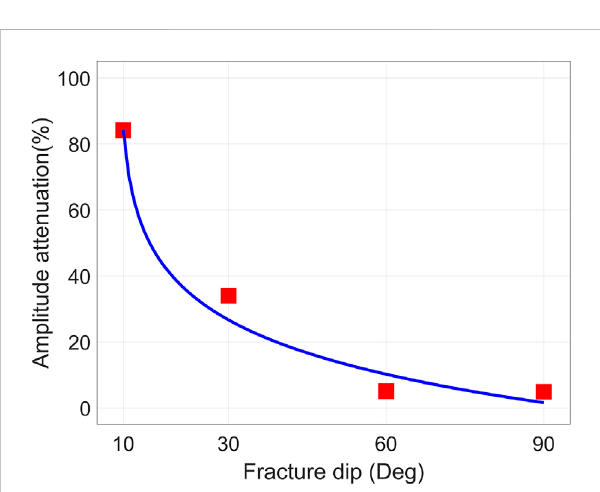
FIGURE 9 Amplitude attenuation of monopole P wave versus different fracture dipangles. Thefracturewidthis40 mmand fi